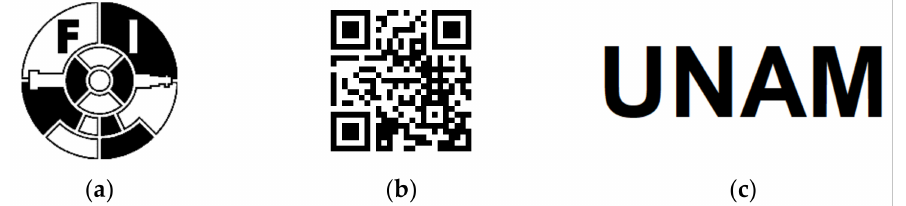
Figure 9. Binary watermark patterns: ( a ) Owner logotype FI, ( b ) QR code level L, and ( c ) Owner logotype UNAM.